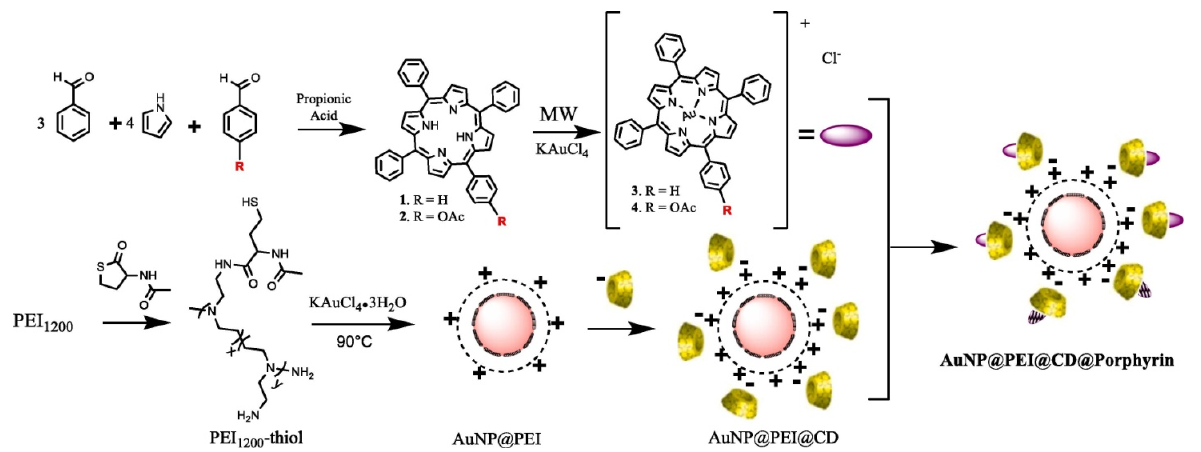
Figure 21. General pathway of AuNP@PEI@CD@Porphyrin synthesis [116].